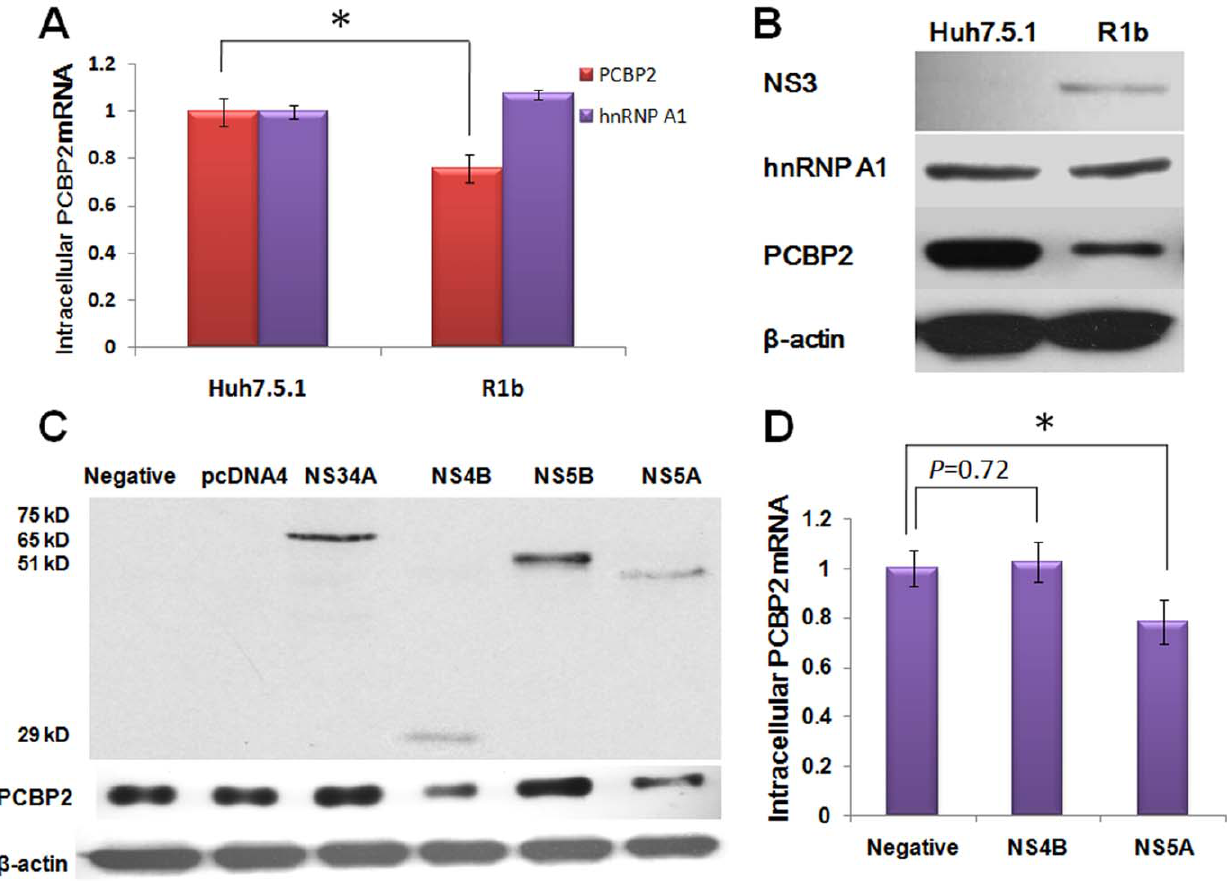
Figure 1. HCV non-structural proteins 4B and 5A mediate the down-regulation of PCBP2 in R1b cells with HCV subgenomic replicon. (A) qRT-PCR detection of PCBP2 mRNA level in Huh7.5.1 cells and R1b cells. The fold-relative enrichment was quantified with normalization to the GAPDH level. The mRNA level of PCBP2 in Huh7.5.1 replicon cells is significantly lower compared with Huh7.5.1 cells ( P , 0.05). (B) Western blotting indicates the down-regulation of PCBP2 protein level in R1b cells. (C) HCV non-structural protein NS4B and NS5A inhibit the expression of PCBP2 in Huh7.5.1 cells. NS4B and NS5A lead to the down-regulated expression of PCBP2 while other NS proteins demonstrate no effect. (D) qRT-PCR detection of PCBP2 mRNA level in Huh7.5.1 cells expressed HCV NS4B or NS5A proteins. NS4B demonstrate no effect on PCBP2 RNA level ( P =0.72), while NS5A can inhibit approximately 22% of PCBP2 RNA level. Each bar represents the average of triplicate data points with the standard deviation represented as the error bar . * P , 0.05 versus negative